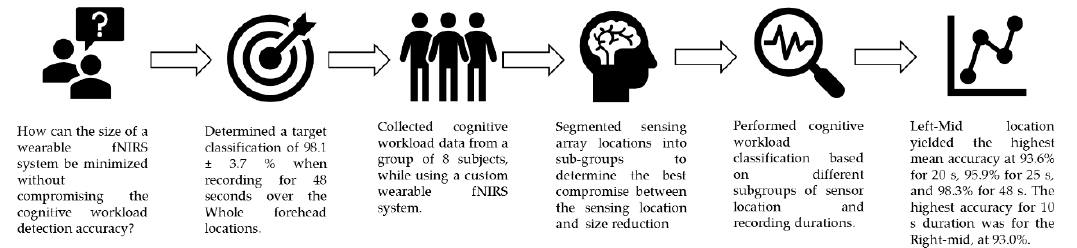
Figure 1. Graphical abstract of the study.